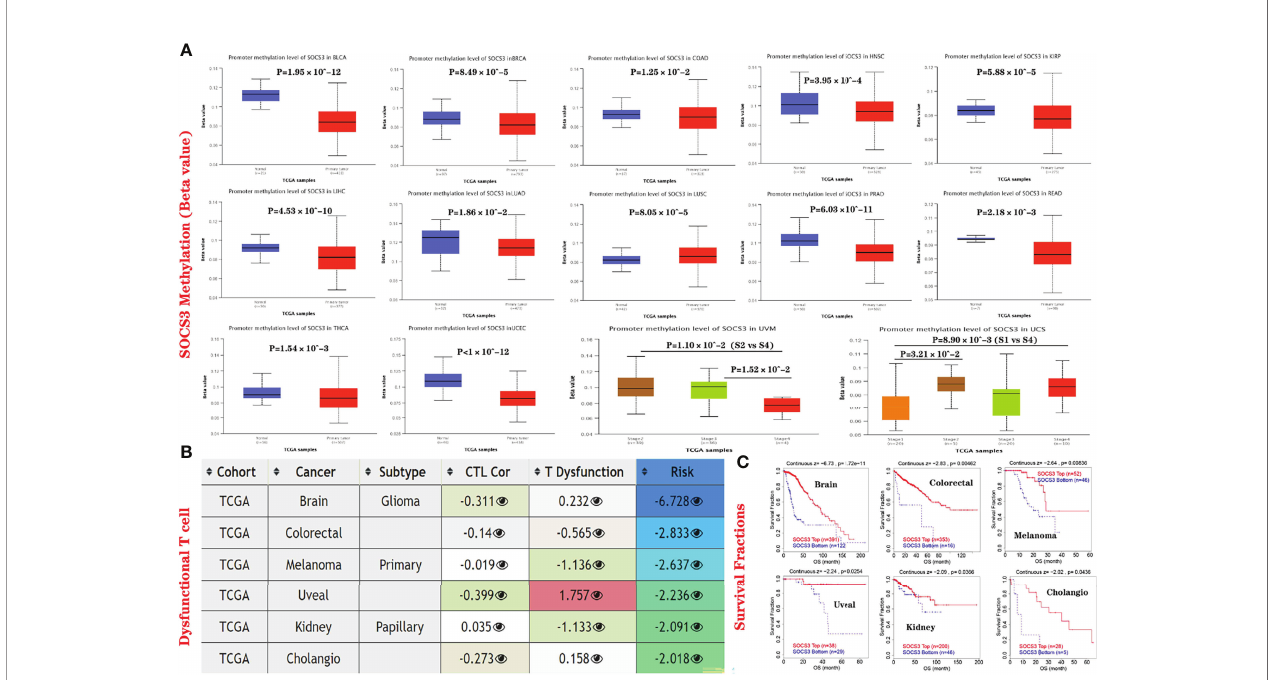
FIGURE 8 | Epigenetic modi fi cations of SOCS3 are related to dysfunctional T-cell phenotypes and poor outcomes in various cancers. (A) UALCAN database was employed to investigate the SOCS3 methylation levels (beta values) in various tumors via TCGA dataset, such as BLCA, BRCA, COAD, HNSC, KIRP, LIHC, LUAD, LUSC, PRAD, READ, THCA, UCEC, UVM, and UCS. (B) Correlations between SOCS3 methylation and cytotoxic T-cell levels (CTLs), dysfunctional T-cell phenotypes, and risk factors in TCGA cancers. (C) Effect of SOCS3 methylation levels on overall survival in TCGA cancer cohorts. We only indicated statistically signi fi cant